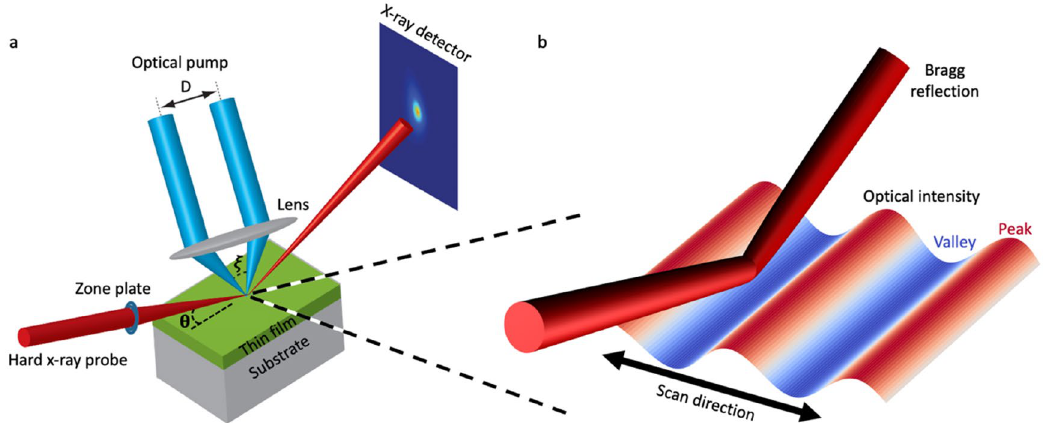
Figure 1. Experimental arrangement for the transient grating pump and focused X-ray diffraction probe (TGXD) technique. ( a ) Two synchronized optical pulses with crossing angle x generate a transient grating on the sample. After a controlled delay, the focused X-ray probe diffracts from the film and is collected by a two- dimensional X-ray detector. ( b ) Zoom-in view of the excited region. Scanning the TG relative to the focused X-ray beam spatially resolves the evolution of the structural